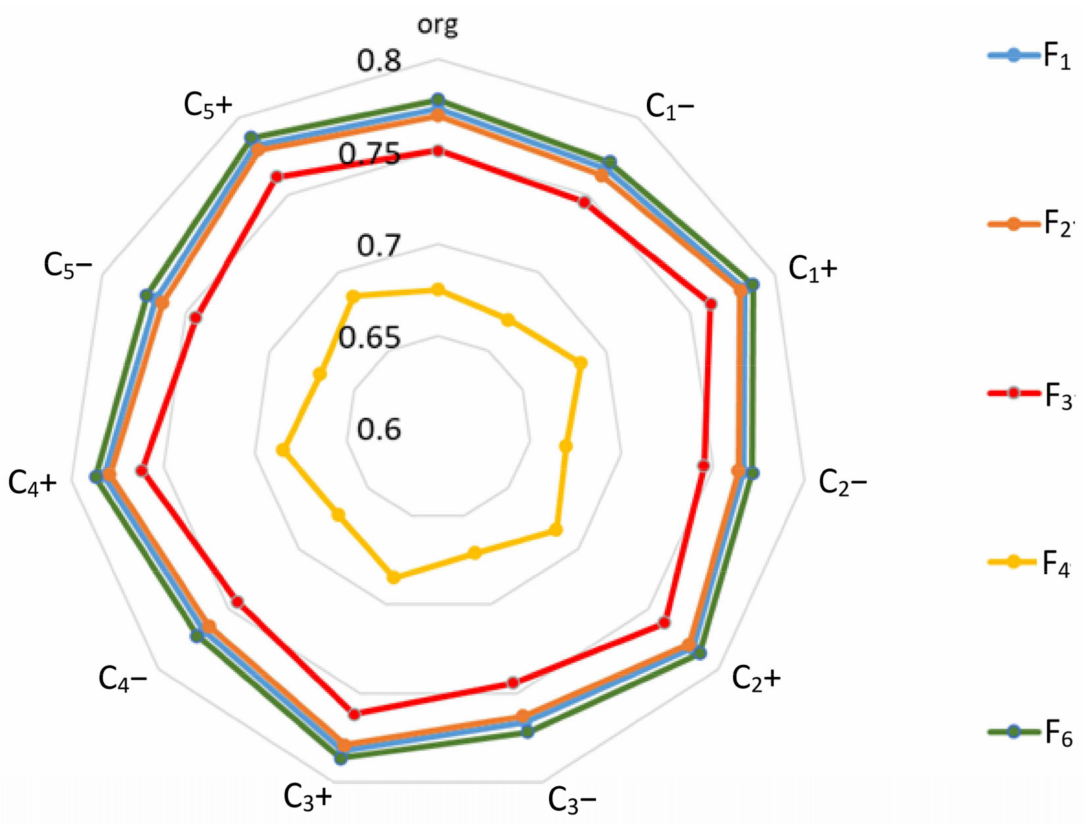
Figure 10. Sensitivity analysis results for the criteria—closeness ratio versus